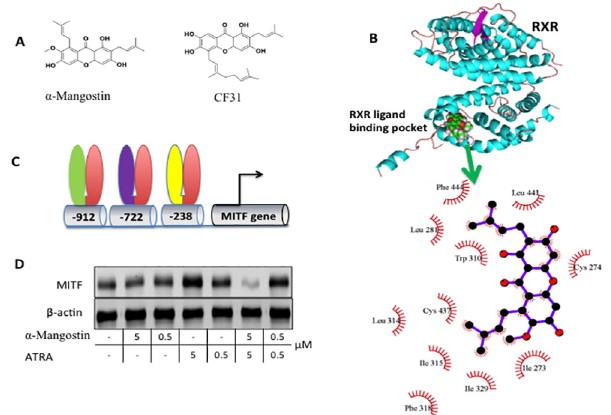
Fig 4. α -Mangostin modulates MITF expression via RXR binding. A. Chemical structure of α -Mangostin resembles CF31, which targets RXR. B, Molecular docking shows that α -Mangostin is accommodated by the RXR ligand binding pocket. In the top panel RXR is cyan and α -Mangostin is shown as spheres. A close-up view of interactions between RXR and α -Mangostin is shown in the bottom. C. Structure of MITF promoter region. The binding sites of VDR/RXR, RAR/RXR D5 and NURR1/RXR are located at position of -912, -722, and -238 respectively. D. ATRA, a RAR activator, significantly induces expression of MIFT in a dose dependent manner but α -Mangostin blocks